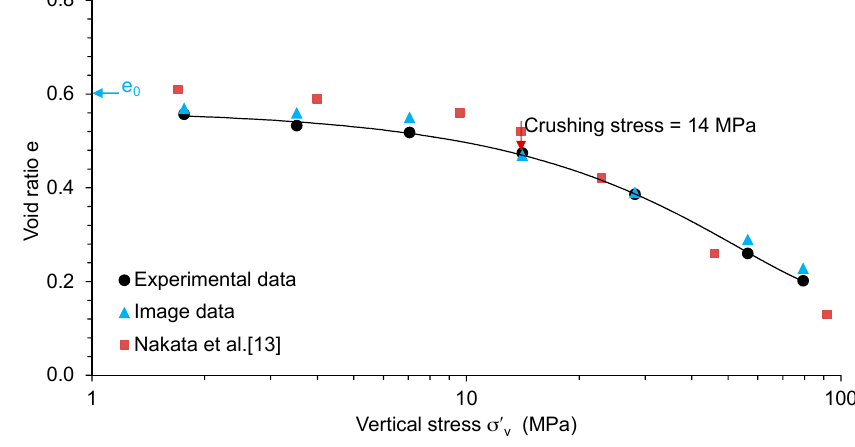
Figure 4. e-log σ ’ v plot for the uniformly graded sand sample.